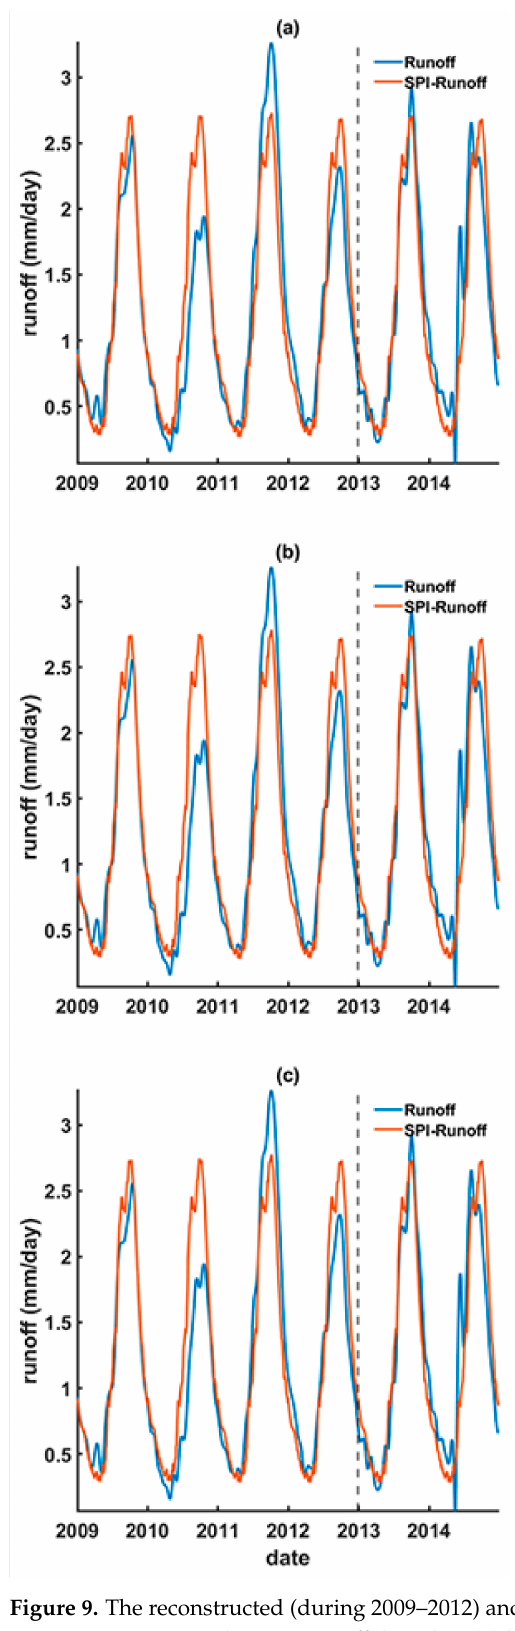
Figure 9. The reconstructed (during 2009–2012) and forecasted (during 2013–2014) runoff using the upstream TRMM SPI (i.e., SPI-runoff) based on ( a ) linear regression, ( b ) ANN, and ( c ) LSTM